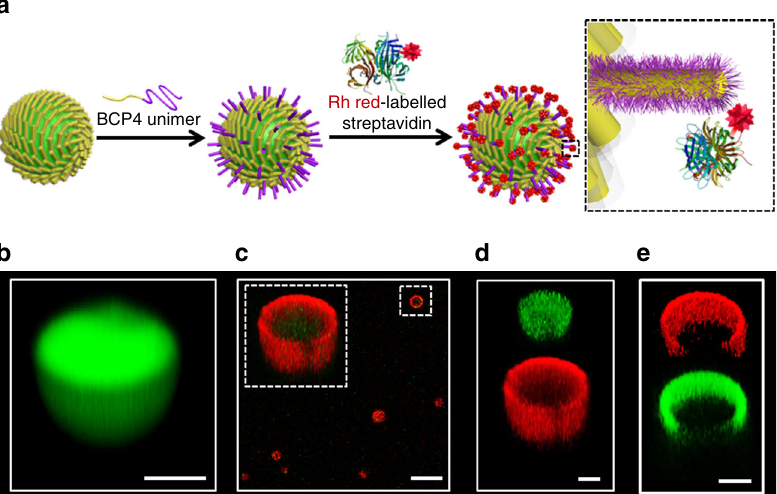
Fig. 4 Biofunctionalization of PFS 25 - b -PMVSCOOH 245 colloidosomes. a Schematic representation showing preparation of biotinylated colloidosomes and membrane binding of streptavidin. Epitaxial attachment of BCP1/BCP4 unimers to the termini of BCP1 cylindrical micelles in the native membrane produces hair-like extensions with biotinylated side chains that serve as sites for streptavidin binding to produce biofunctionalized colloidosomes. b – d Confocal fl uorescence microscopy images of crosslinked colloidosomes prepared by interfacial assembly of FITC – dextran-containing size-speci fi c ( L L w / L n = 1.01) BCP1 cylindrical micelles; b image showing green fl uorescent interior in the native colloidosome con fi rming presence of encapsulated FITC – dextran ( M w = 70,000); c , d after addition of BCP1/BCP4 (1:1 weight ratio) unimers and subsequent conjugation of rhodamine-labelled streptavidin. Z -stack micrographs of individual colloidosomes based on merged green / red channel image ( inset of c ), and green or red channel images ( d ) con fi rm biotin- mediated binding of streptavidin to the epitaxially extended membrane of the colloidosomes. Samples were prepared in water/isopropanol mixtures at a volume ratio of 4:1. e Conjugation of biotinylated fl uorescein – dextran to the hair-like membrane extensions of streptavidin-decorated biotinylated BCP1 water- fi lled colloidosomes; Z -stack micrographs of individual colloidosomes recorded in red or green channels con fi rming binding of biotinylated fl uorescein – dextran to the rhodamine red – streptavidin functionalized colloidosomes. Samples were prepared in water/isopropanol mixtures at a volume ratio of 4:1. Scale bars in b , d and e , 2 µ m. Scale bar in c , 10 µ